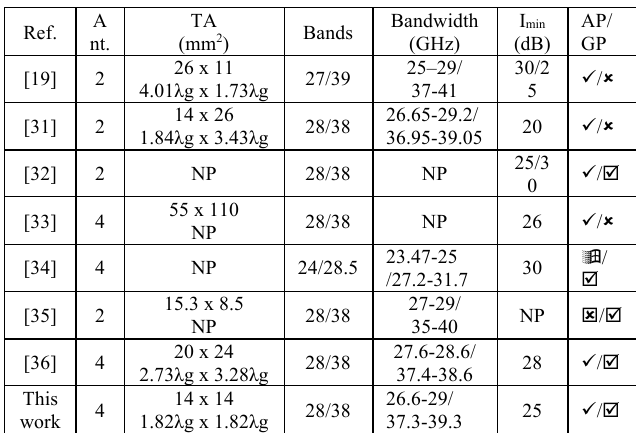
T ABLE III. Comparison between different dual-band MIMO antenna performances reviewed in literature